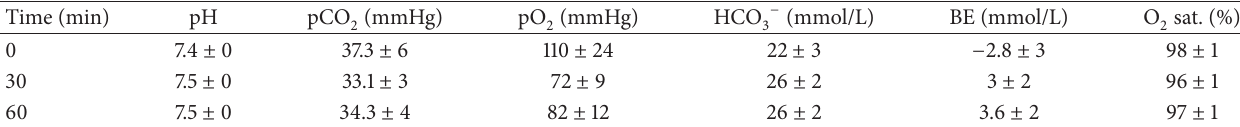
Table 4: Mean ± SD values for venous hydrogen ion concentration (pH), carbon dioxide partial pressure (pCO ), bicarbonate (HCO 3− ), base excess (BE), and haemoglobin oxygen saturation (O (pO 2 (IPPV) with peak inspiratory pressure of 4cmH cockatoos ( Cacatua galerita galerita ).